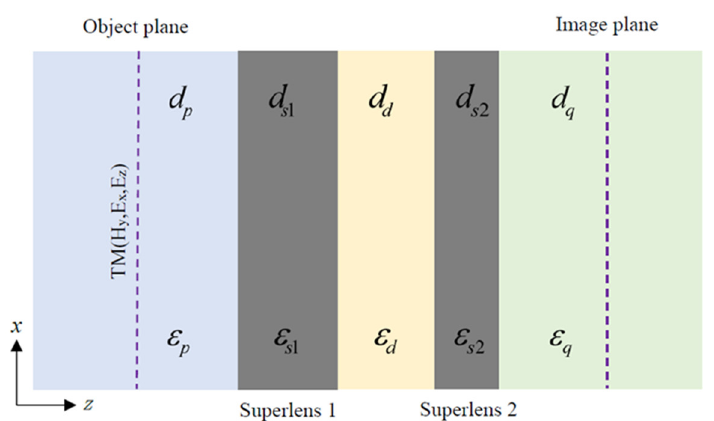
Figure 1. Near-field subwavelength imaging system of double-layer metal superlens.